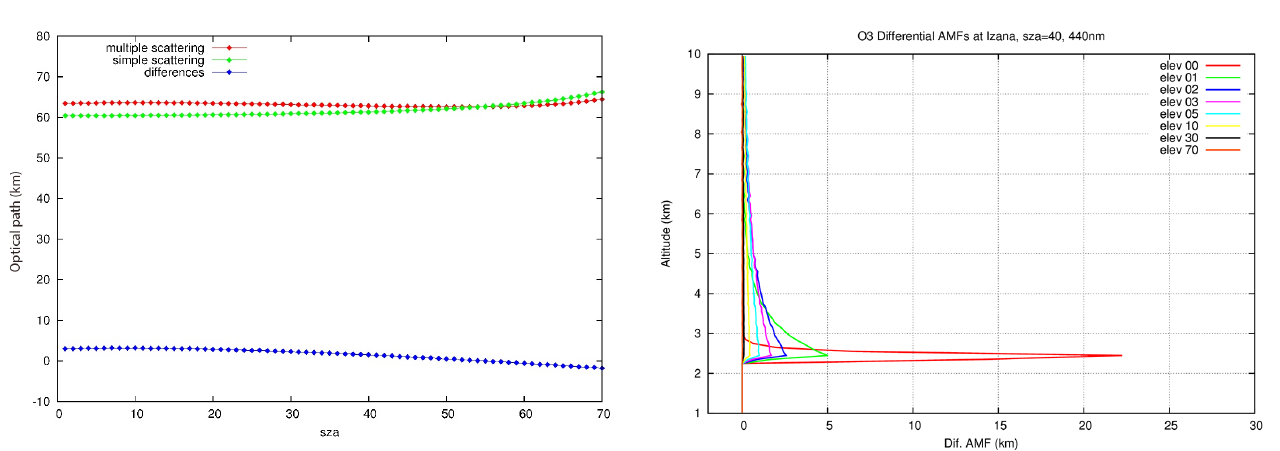
Figure 3. Differential box-AMFs (with respect to the zenith) for the Izaña observatory. The calculations were performed at